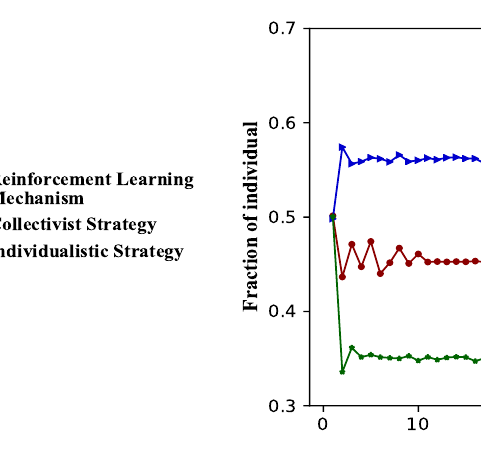
Figure 7. The dynamics of community vaccine coverage under the reinforcement learning mechanism when c = 0.5. The level of vaccine coverage fluctuated in the first 10 seasons and then stabilized. The first 10 seasons are called the shocking season, and the following stable seasons are called the stationary season.